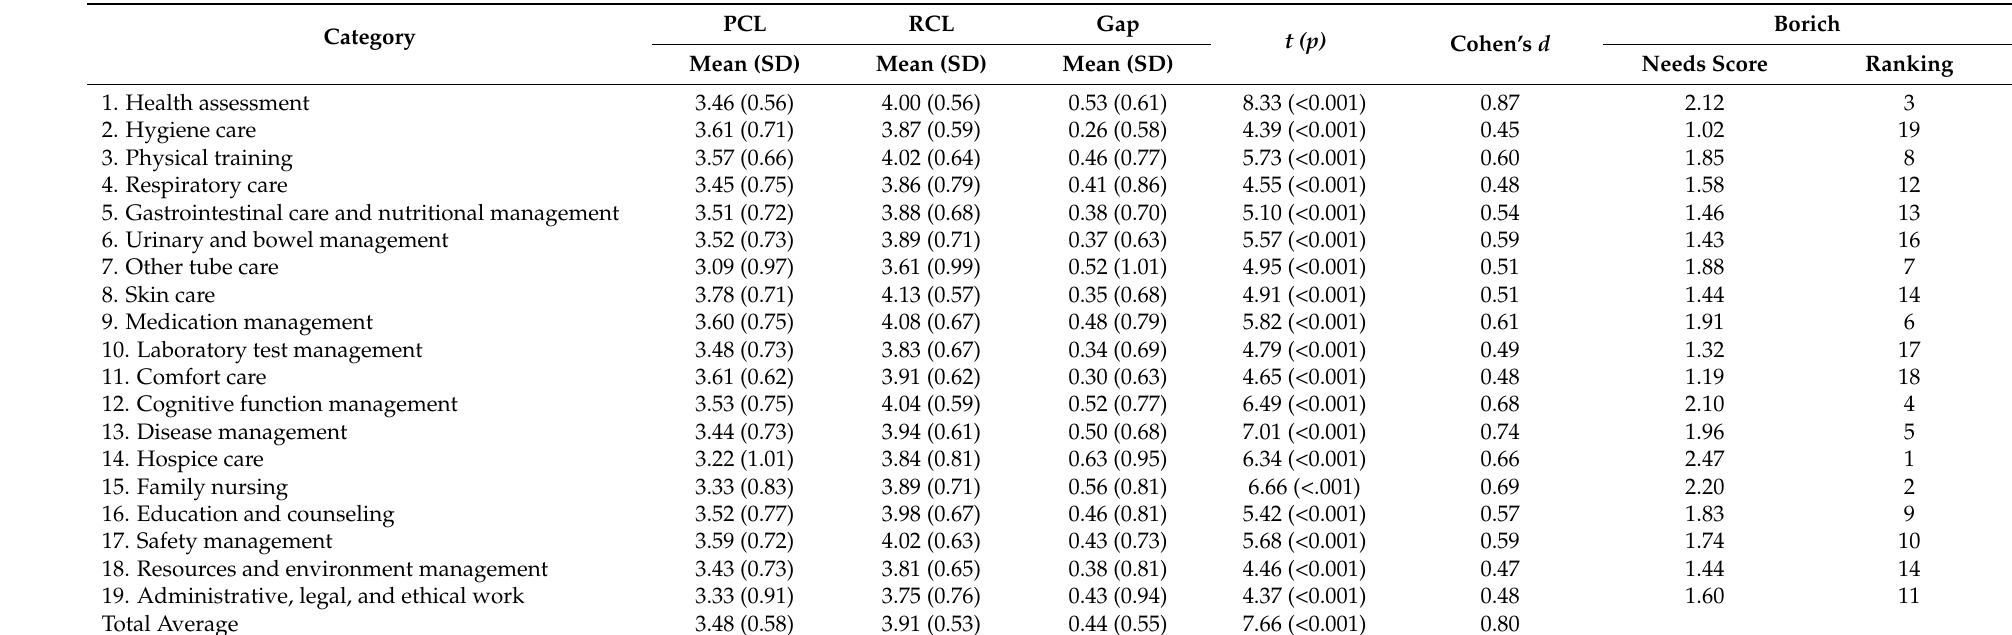
Table 2. Educational needs in home visit nursing ( N =